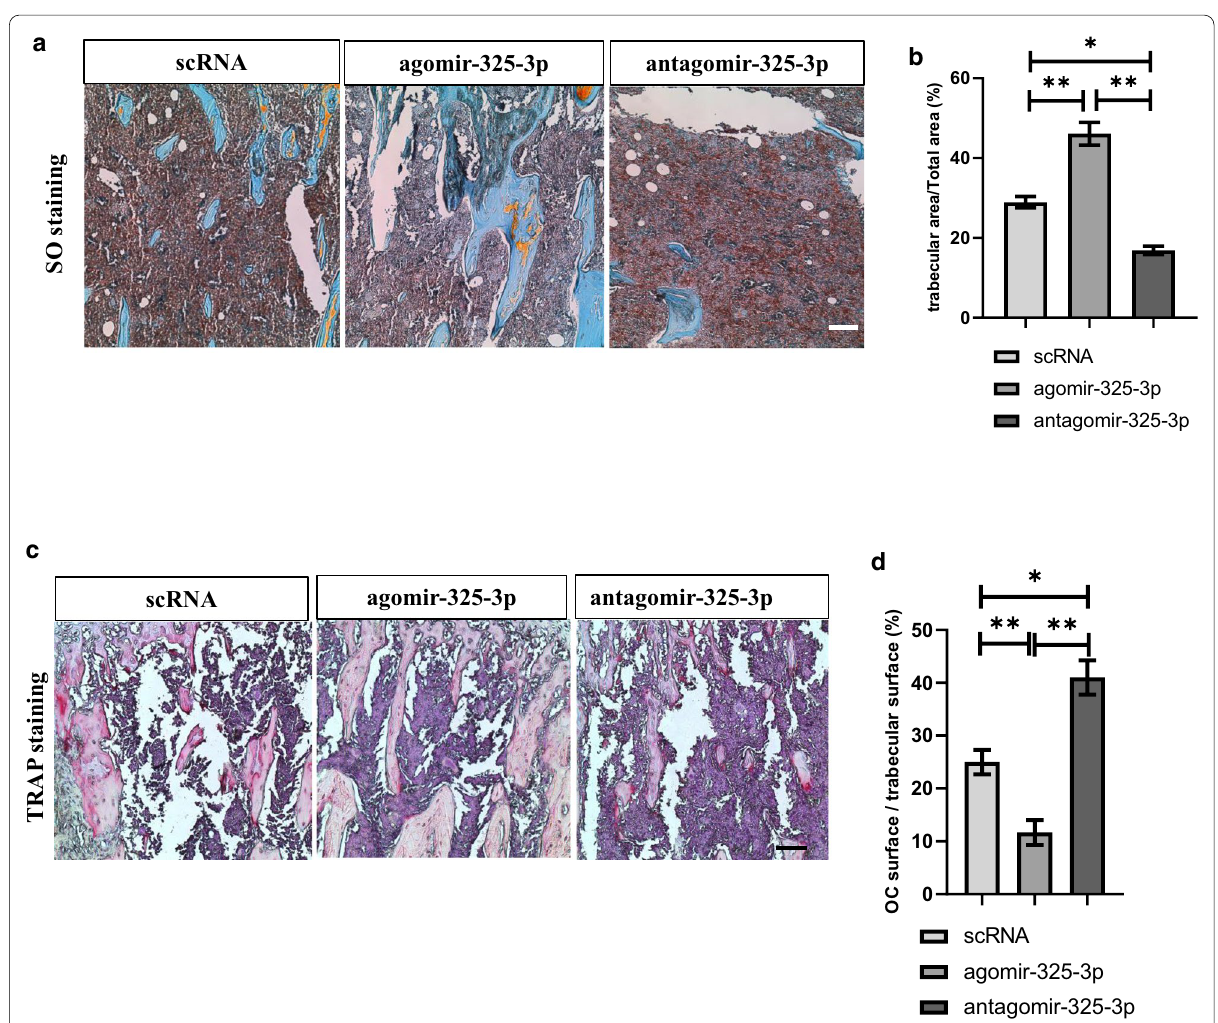
Fig. 5 MiR-325-3p treatment attenuates bone resorption in bone metastasis of CRC. a The agomir-325-3p or antagomir-325-3p or their controls were injected through lateral veins weekly for three weeks after injection of CT-26 cells intratibially. The samples were collected and sectioned. Safranin O-Fast Green staining revealed trabecular area in each group (Scar bar trabecular area in ( a ) (mean SE). c TRAP staining revealed TRAP positive cells in trabecular area (Scar bar ± d Quantification of osteoclast surface comparing with trabecular surface in ( c ) (mean times.*p < 0.05, **p < 0.01, ***p <